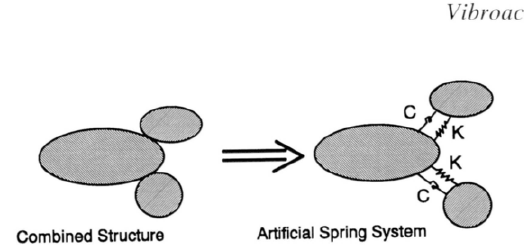
FIGURE 3 Schematic representation of the coupling modeling using the artificial spring